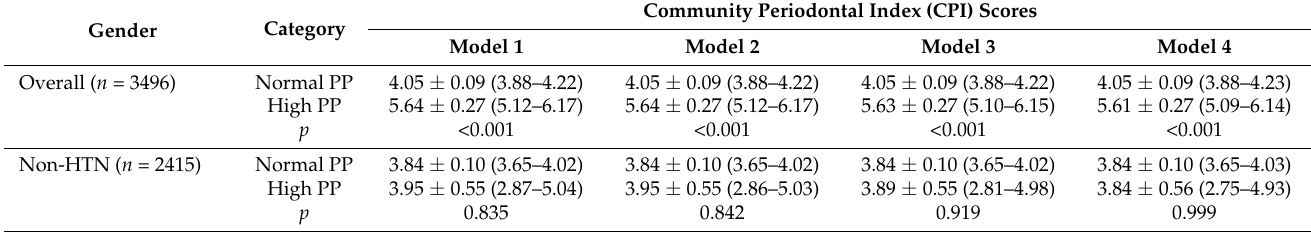
Table 4. Comparisons of the community periodontal index scores and pulse pressure in overall, non-HTN, and HTN